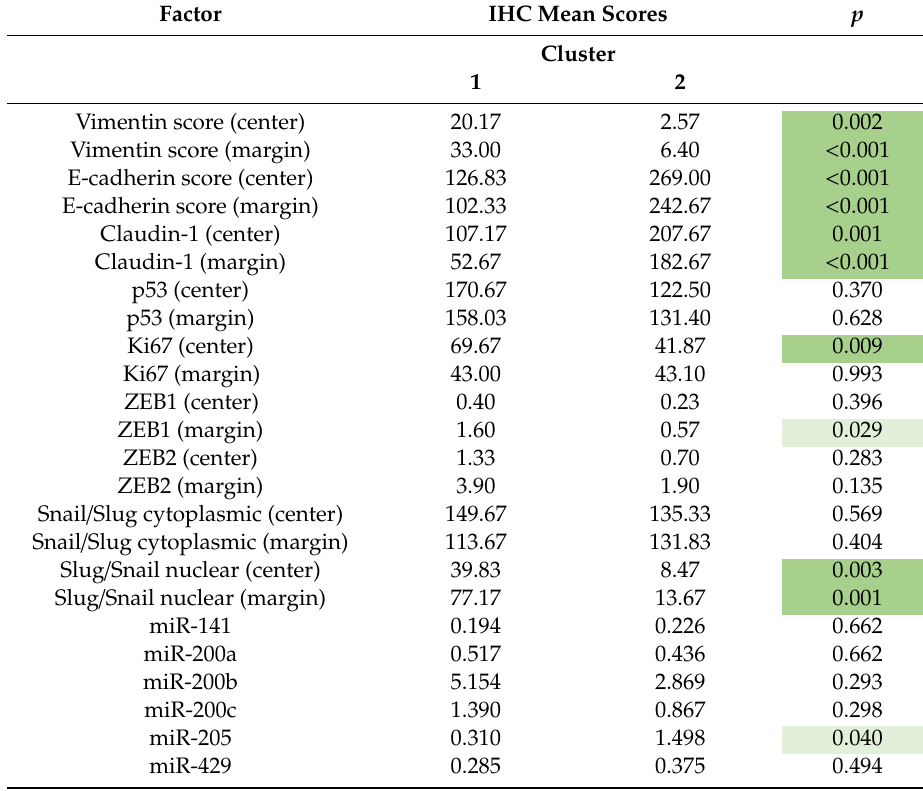
Table 3. K-means cluster analysis of EMT and proliferation markers.